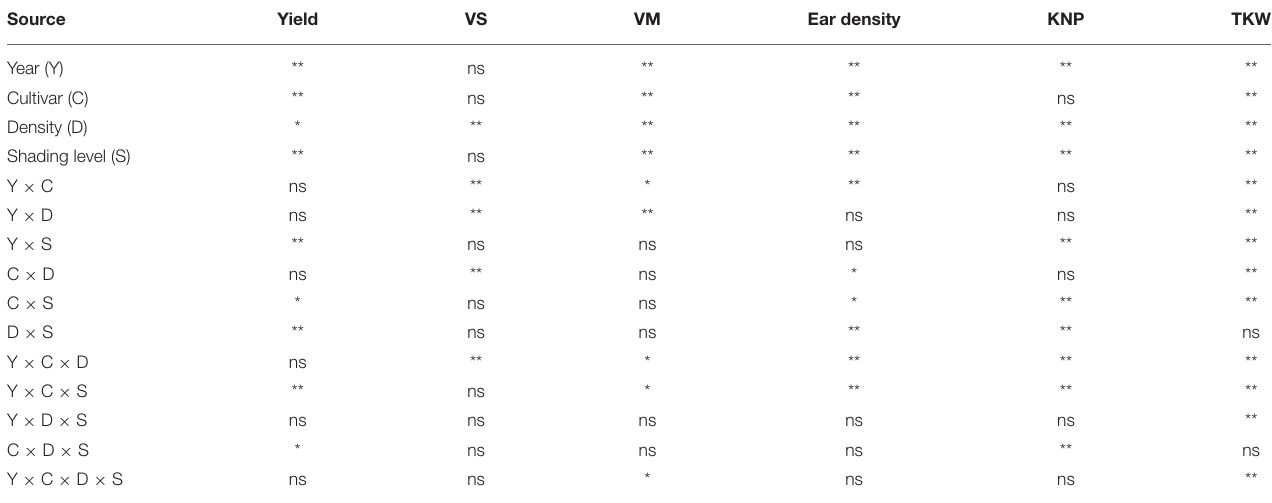
TABLE 3 | ANOVA analysis for the effects of year, cultivar, planting density and shading level on the grain yields, yield components (KNP, kernel number per ear. TKW, thousand-kernel weight) and dry weights of plant organs (dry matter of vegetative organs at silking [VS] and at maturity [VM]).